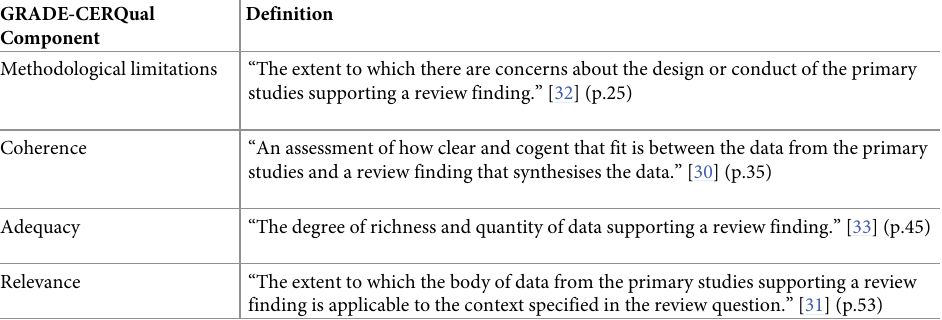
Table 1. Overview of the four components of the GRADE-CERQual approach for assessing confidence in findings of reviews of qualitative